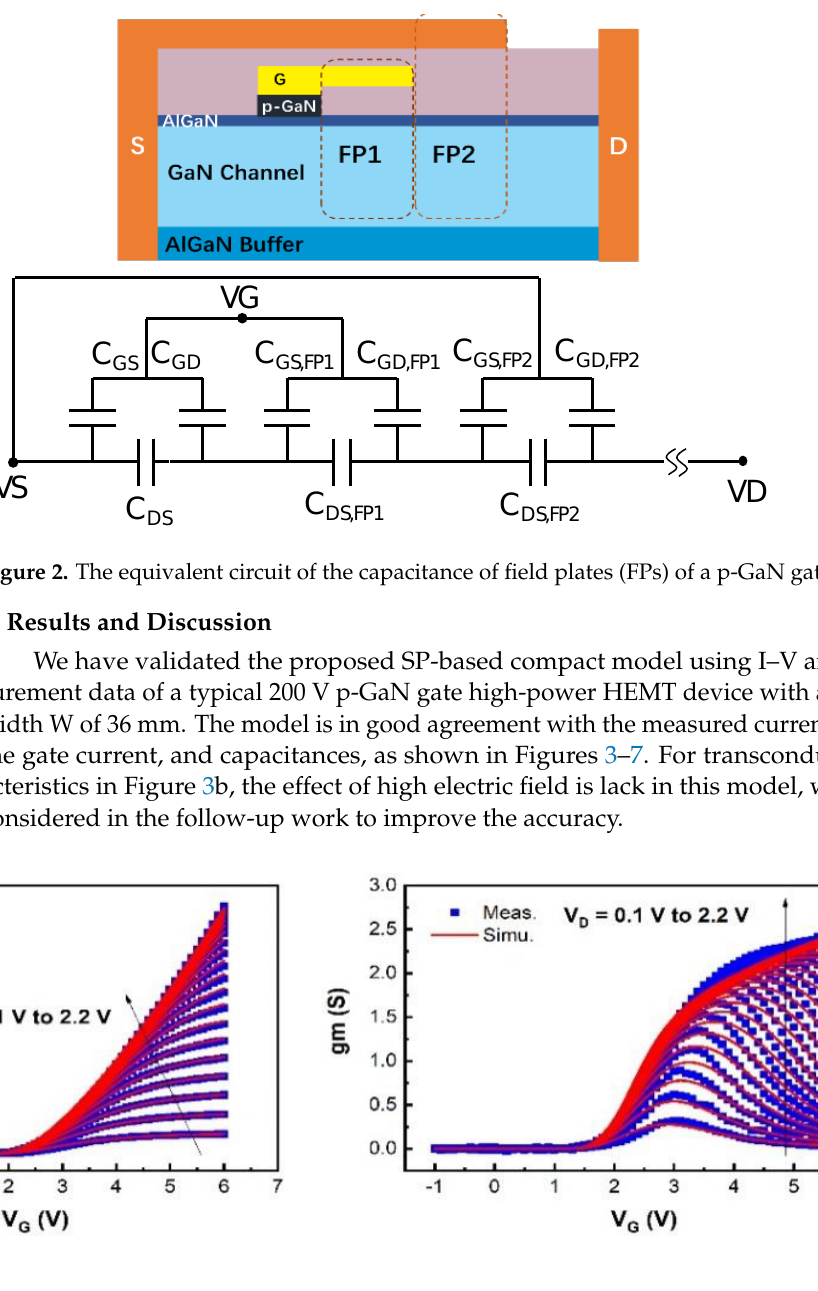
Figure 3. Measurement data (dots) and simulation data (line) at 300 K with V D from 0.1 to 2.2 V, step = 0.1 V. ( a ) Transfer characteristics; ( b ) transconductance characteristics.